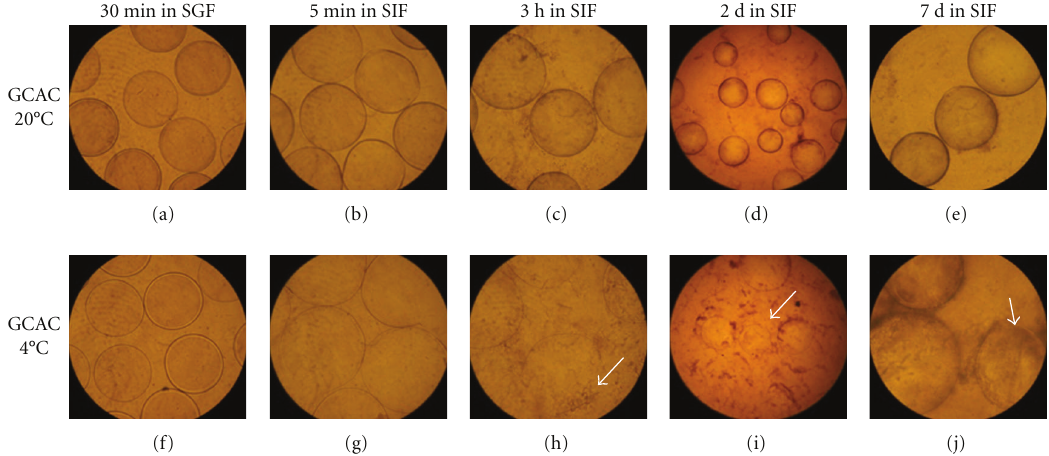
Figure 15: Microphotographs of GCAC microcapsules cross-linked at 20 ◦ C (a)–(e) and at 4 ◦ C (f)–(j) after sequential incubation in simulated gastric fluid and simulated intestinal fluid. Original magnifications were 90 × (a)–(c), (e), (f)–(h), and (j) and 35 × (d) and